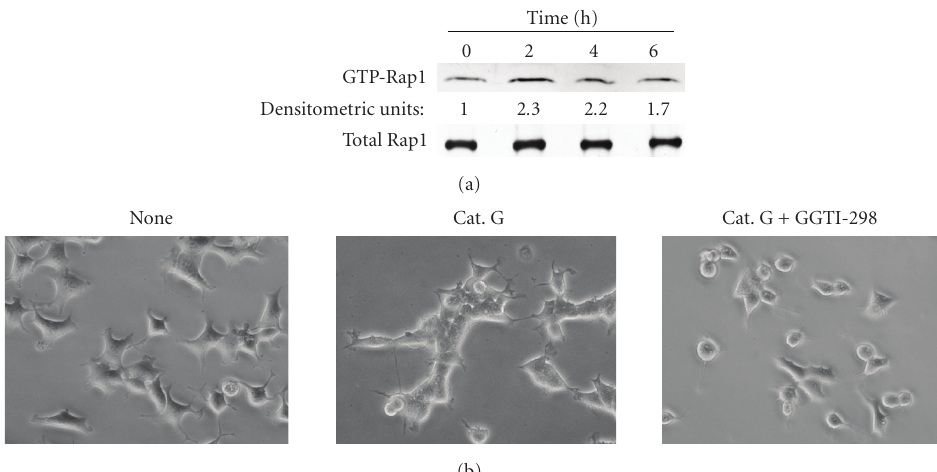
Figure 4: Rap1 activation is involved in induction of cell condensation by cathepsin G. (a) MCF cells were cultured in dishes coated with fibronectin. After 24 hours, the adherent cells were incubated in serum-free medium with 0.5 mU/mL cathepsin G for the indicated periods. Active Rap1 was analyzed by the pull-down assay. Western blotting of whole cell lysates was used to assess total levels of Rap1 (Total Rap1). The densitometric units represent Rap1 activity relative to cathepsin G-untreated cells (0 hour) taken as 1.0. (b) The adherent MCF-7 cells were treated with cathepsin G in the absence or presence of a Rap1 inhibitor GGTI-298 (5 μ M) for 5 hours. Cells were then analyzed by phase-contrast microscopy original magnification: × 200.